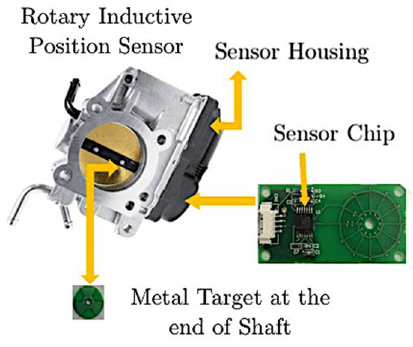
Figure 5. State-of-the-art inductive-based E-Gas actuator position sensor system. Reproduced from [23]. Copyright 1998-2020, Microchip Technology Inc.